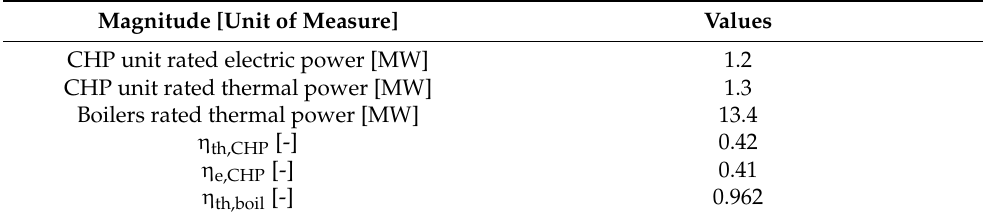
Table 1. Technical data of the CHP unit and